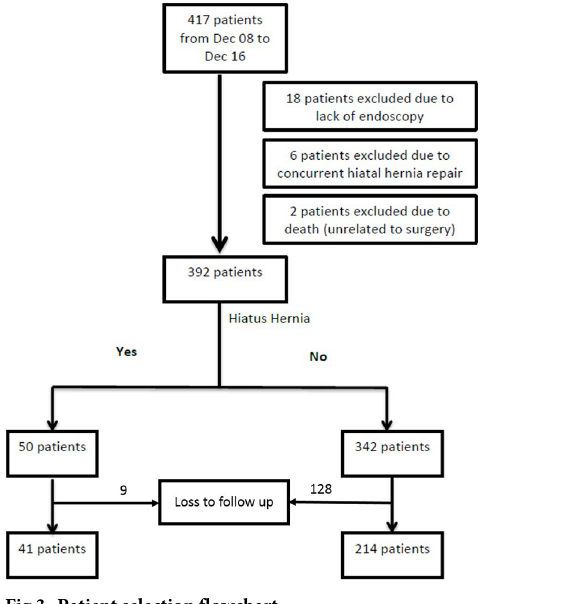
Fig 3. Patient selection